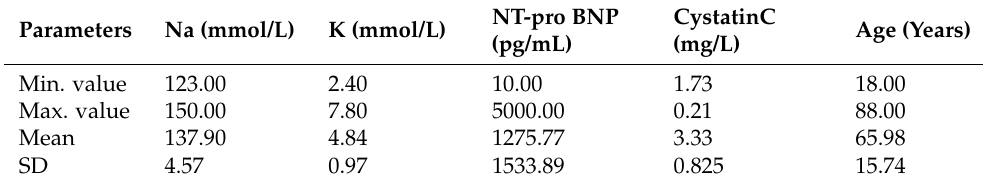
Table 1. Demographic and laboratory characteristics of respondents.